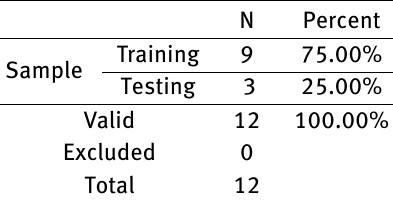
Table 4: Case Processing